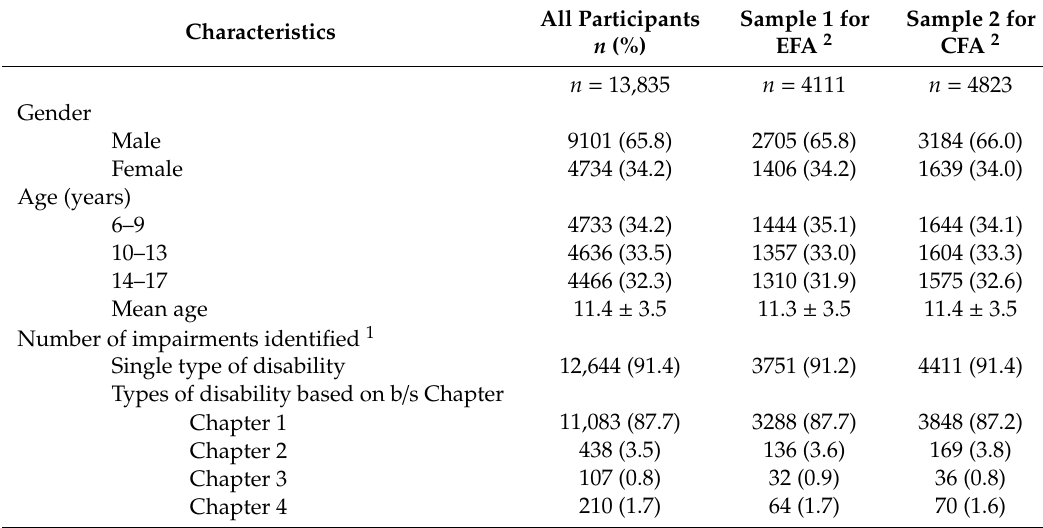
Table 2. Characteristics of the study